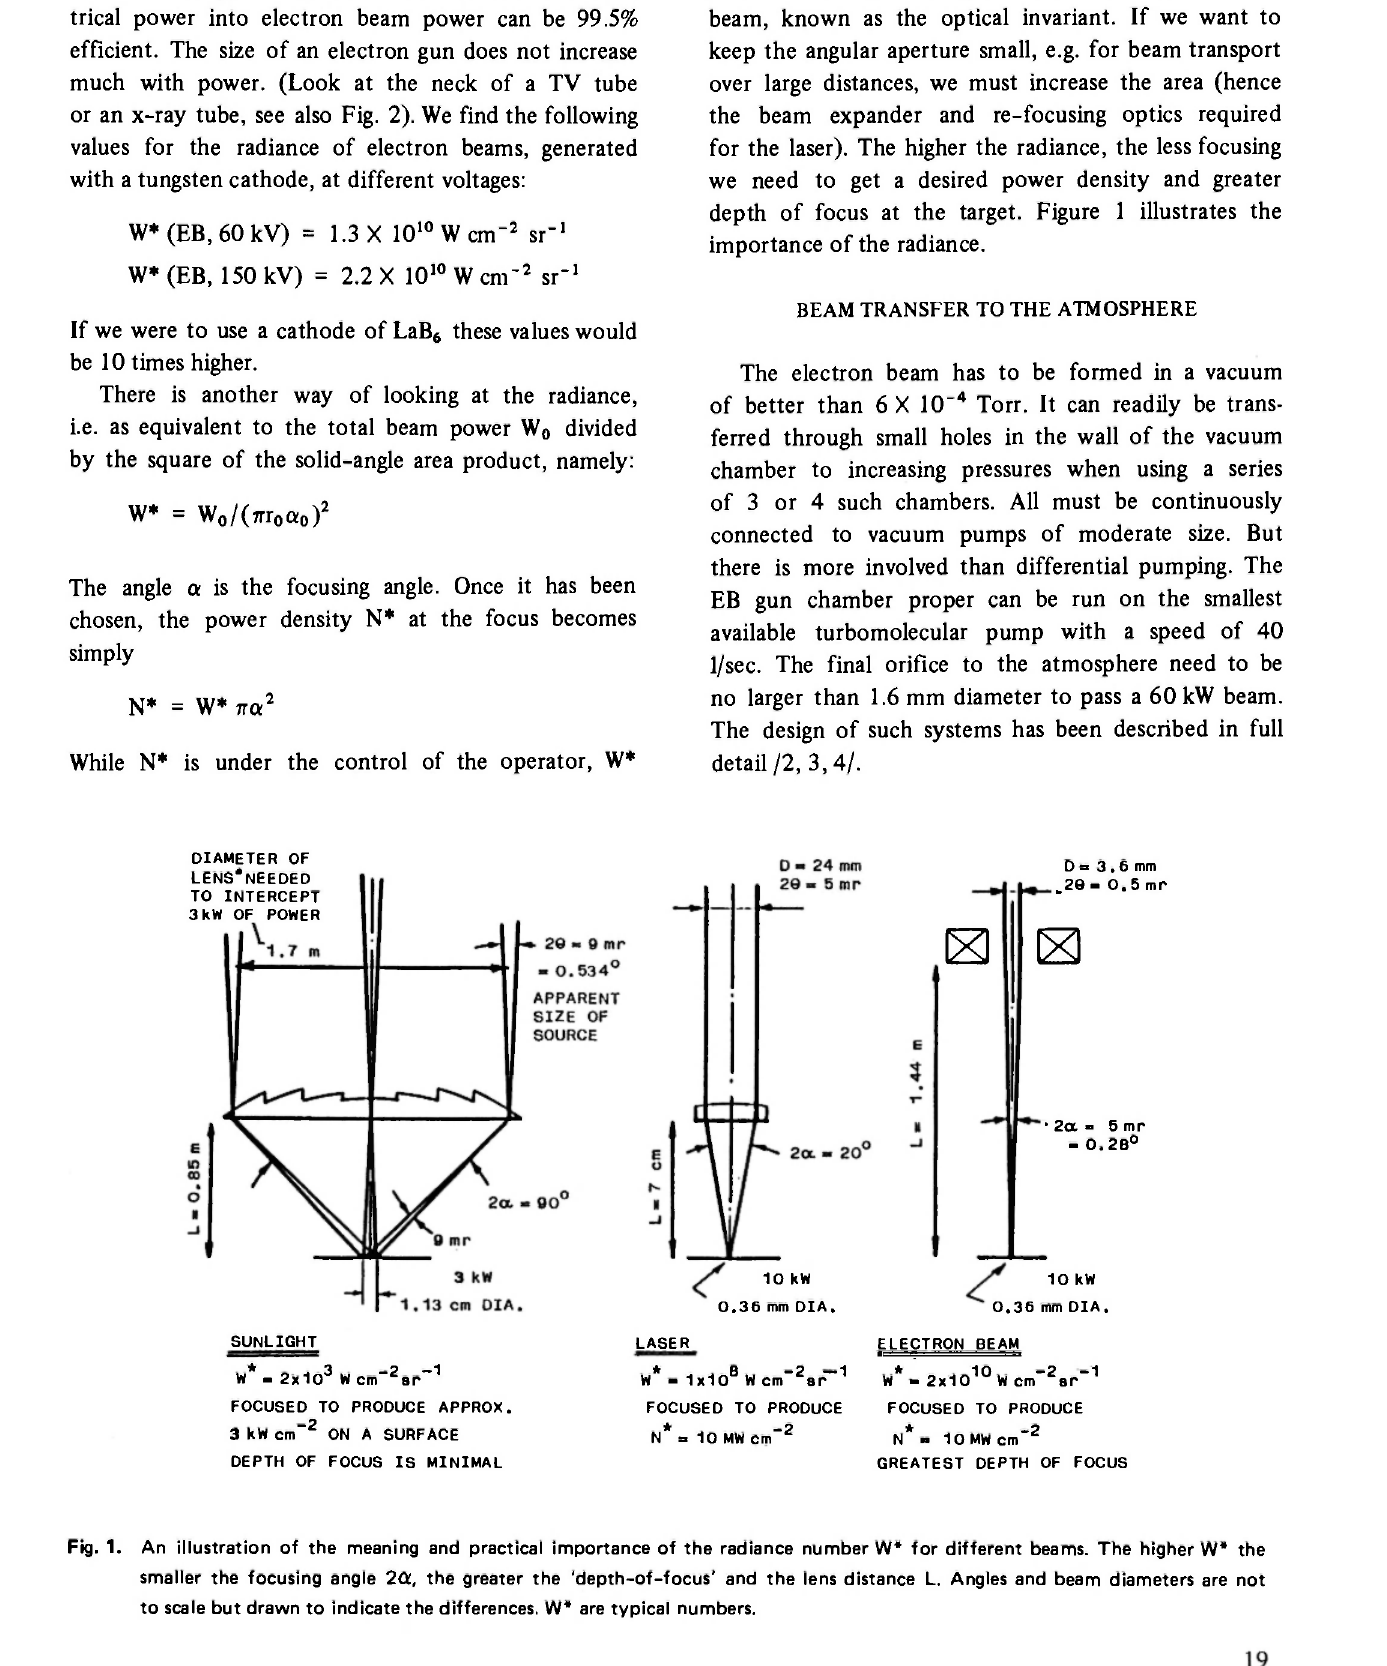
Fig. 1. An illustration of the meaning and practical importance of the radiance number W* for different beams. The higher W* the smaller the focusing angle 2Ά, the greater the 'depth-of-focus' and the lens distance L. Angles and beam diameters are not to scale but drawn to indicate the differences. W* are typical